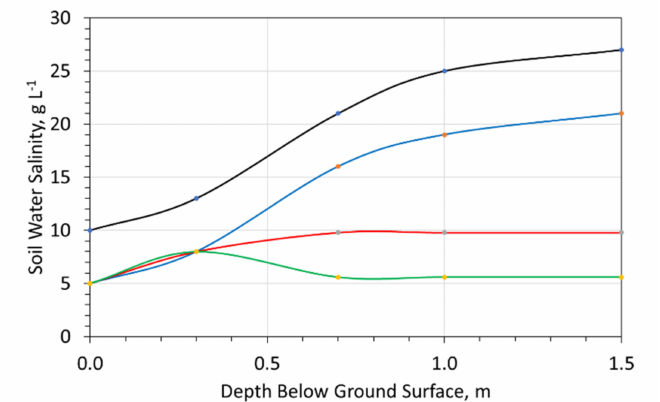
Figure 24. Raised Field Irrigation Scheme-Soil Water Salinity vs. depth below ground surface. Black line = no irrigation; Blue line is irrigation with 14 g NaCl L − 1 ; Red and Green lines are the expected soil salinity range following irrigation with 14 g NaCl L − 1 , where the ZVI desalination treatment product placed at about 0.7 m depth within the raised